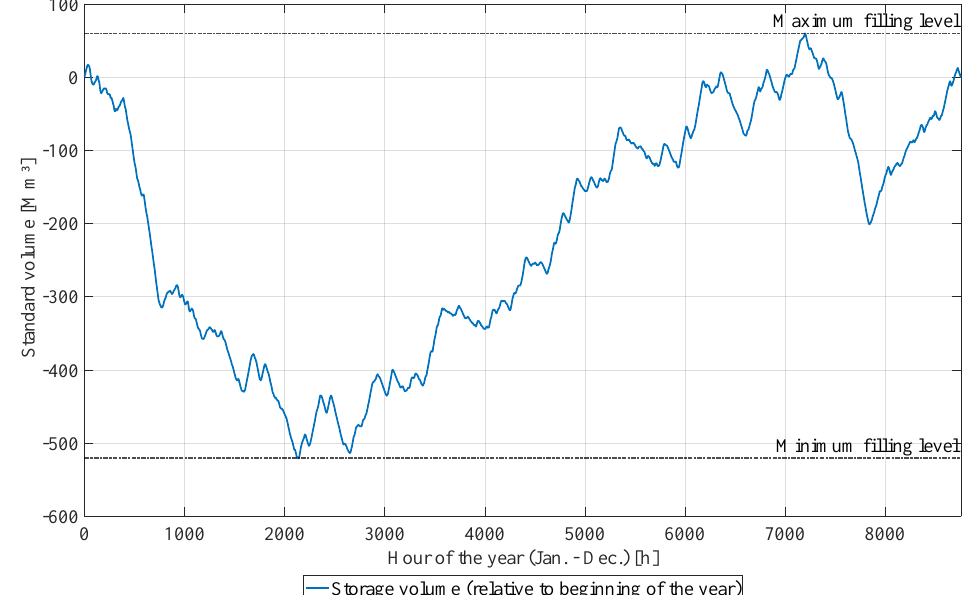
Figure 5. Cumulative hydrogen storage profile over the course of a calendar year for calculating the necessary working gas volume of the cavern. The necessary storage volume is shown relative to the beginning of the